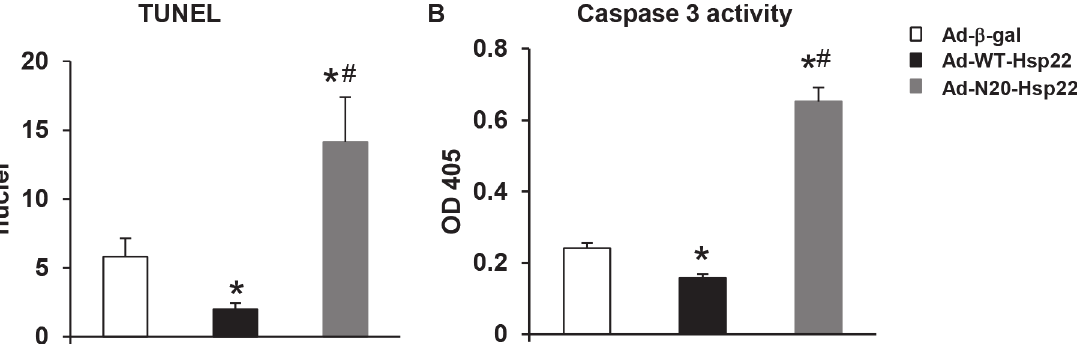
Fig 4. Mitochondrial localization of Hsp22 is necessary for cellular protection in cardiac myocytes. Apoptosis measured by TUNEL and caspase-3 activity in RNCMs infected with the β -Gal control, Ad-WT-Hsp22 or Ad-N20-Hsp22 with chelerythrine. * , P < 0.05 versus β -Gal; #, P < 0.05 vs Ad-WT-Hsp22. n = 5 per